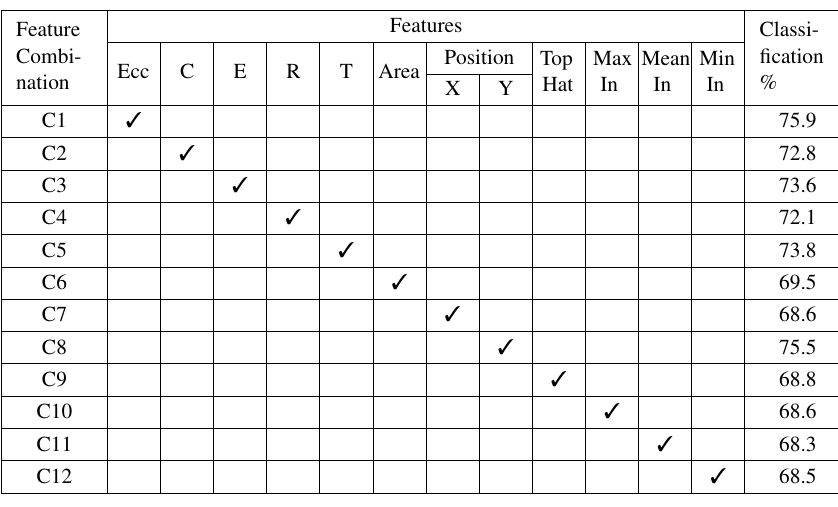
Table 3. Classification with single